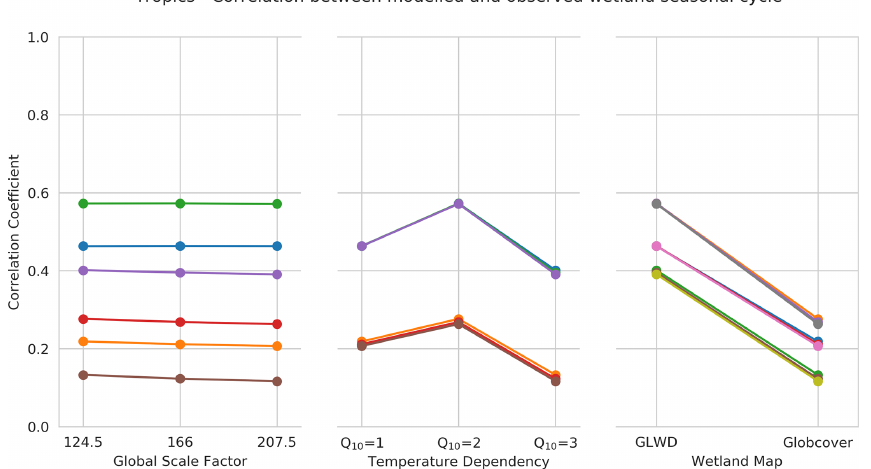
Figure 5. For each of the three parameters that vary within the ensemble (global scale factor, temperature dependency and wetland extent map), we plot the correlation coefficient between the modelled and observed wetland CH 4 seasonal cycle. We join data points where the other two parameters are kept constant, and the only change is due to the specified parameter. The line colours are to indicate the different combinations within each panel. Due to the nature of the plot, there is no link between colours in different panels as they represent different pairs or trios of data. For example, for temperature dependency, we join the three data points where the temperature dependency varies between Q 10 = 1, Q 10 = 2 and Q 10 = 3 but the wetland map and the global scale factor are the same for the three joined data points. This allows the influence of the change in each individual parameter to be assessed.